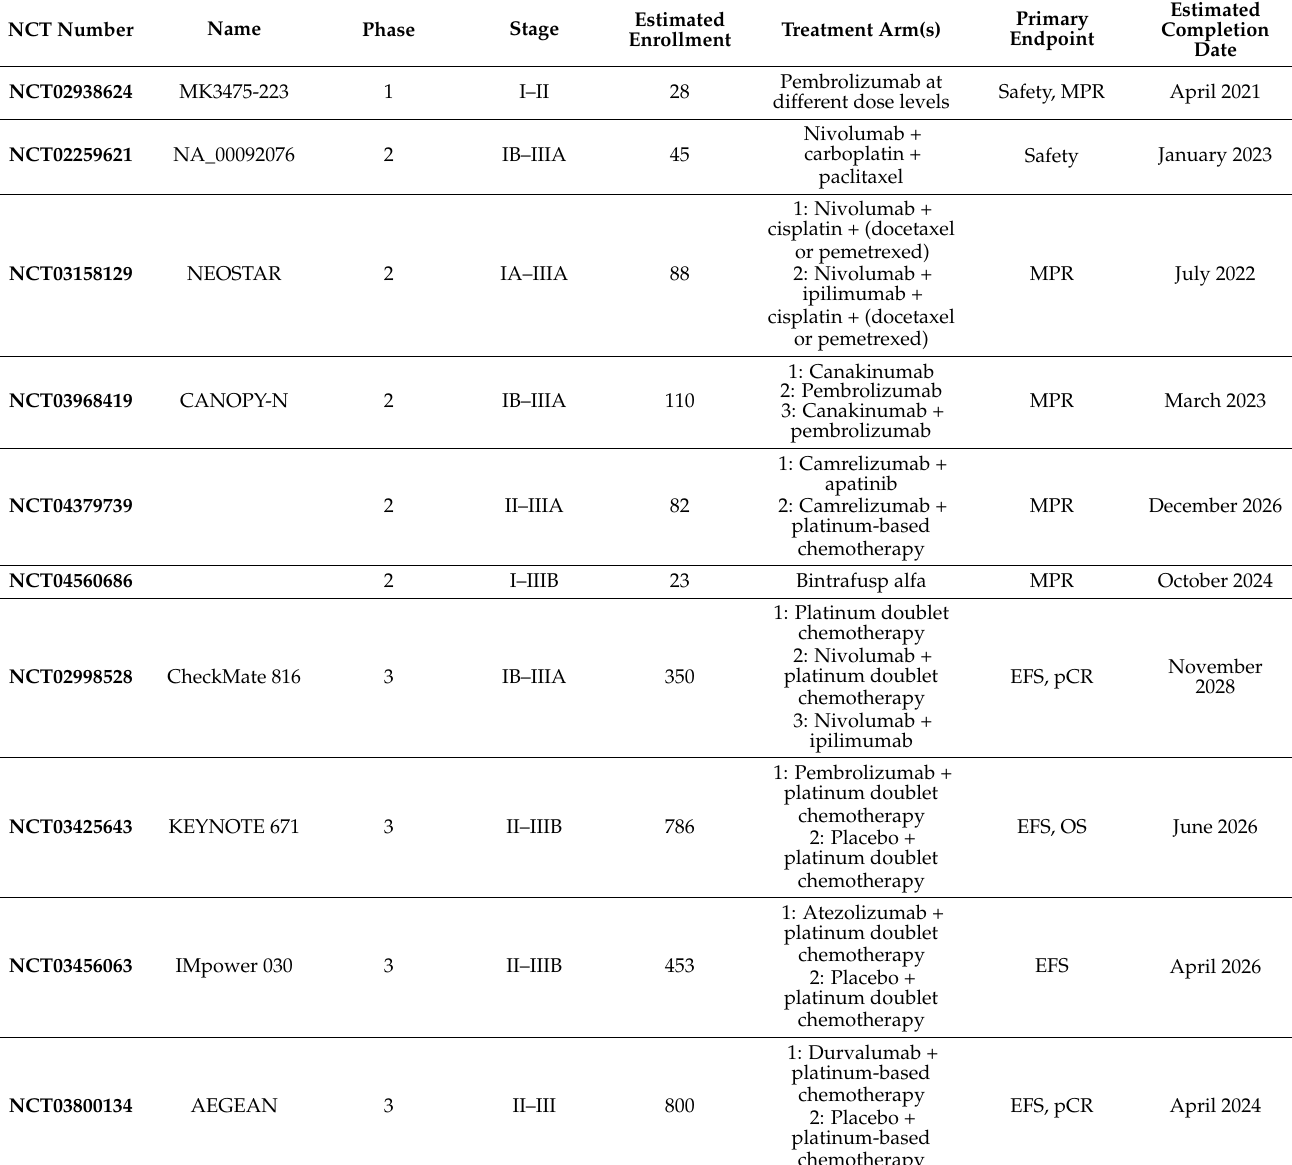
Table 3. Selected ongoing clinical trials that included neoadjuvant immunotherapy in resectable